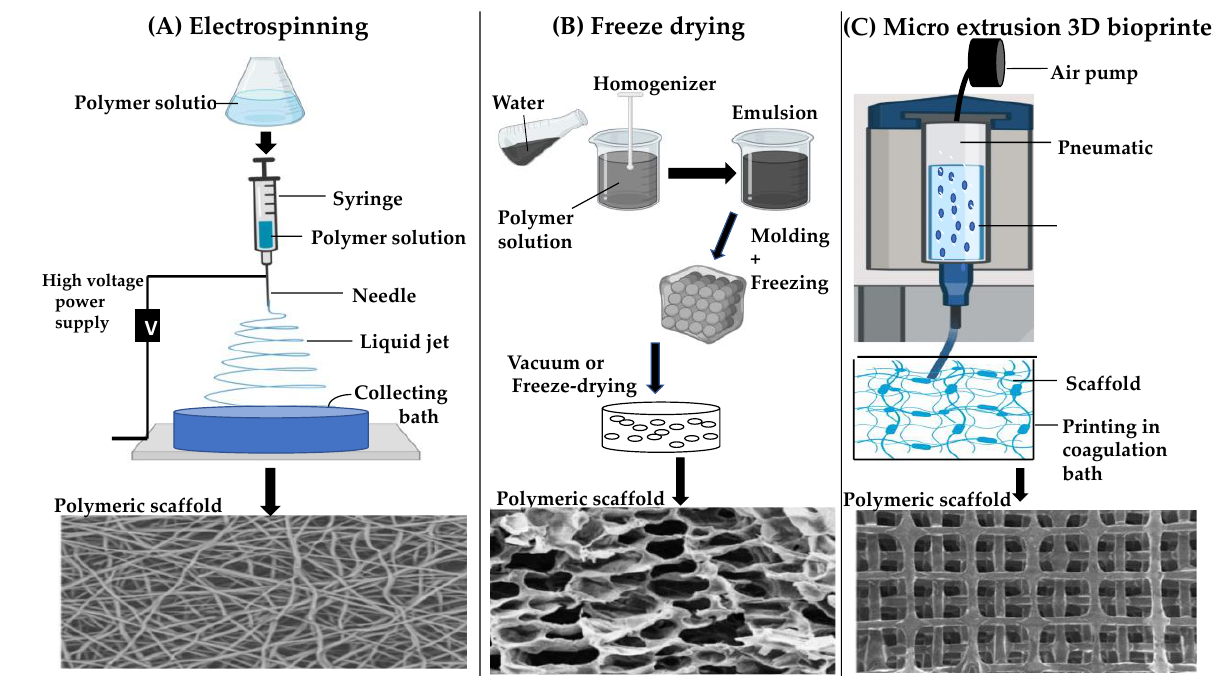
Figure 3. Schematic illustration of different techniques for manufacturing 3D tissue scaffold and optical, SEM images of the printing constructs [108–110].